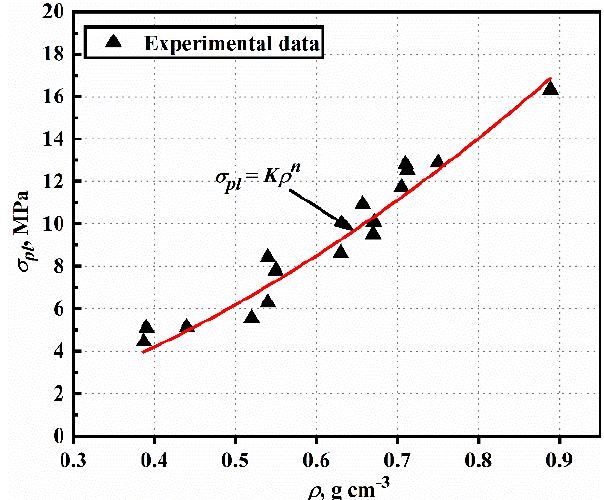
Figure 4. The relationship between density and plateau stress.